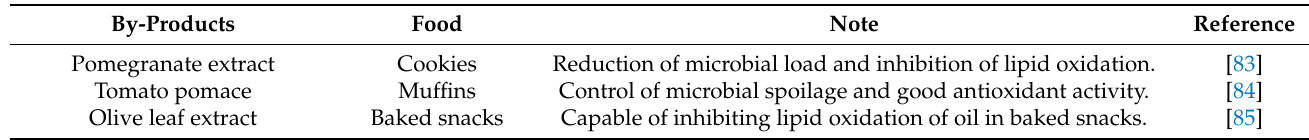
Table 6. Applications of by-products to cereal-based food. By-Products Food Reduction of microbial load and inhibition of lipid